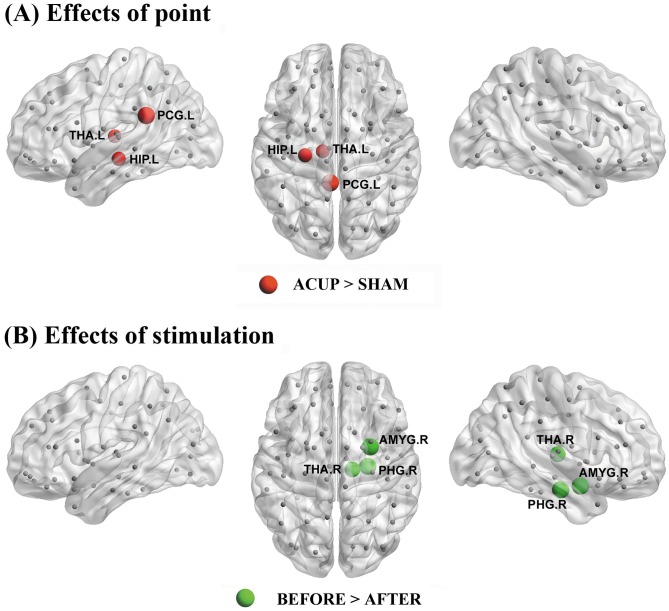
Regions showing significant point- (A) and stimulation- (B) related differences in regional nodal homogeneity.The node sizes indicate the effects (i.e., t values) of interest on nodal degree. The threshold was P<0.05 (uncorrected). Note that the connectivity backbone (sparsity  = 5%) was obtained by thresholding the mean correlation matrix across all subjects and conditions. For more details, see Table 4. ACUP, acupuncture at ST36; SHAM, acupuncture at sham point; Before, before stimulation; After, after stimulation; L, left; R, right.